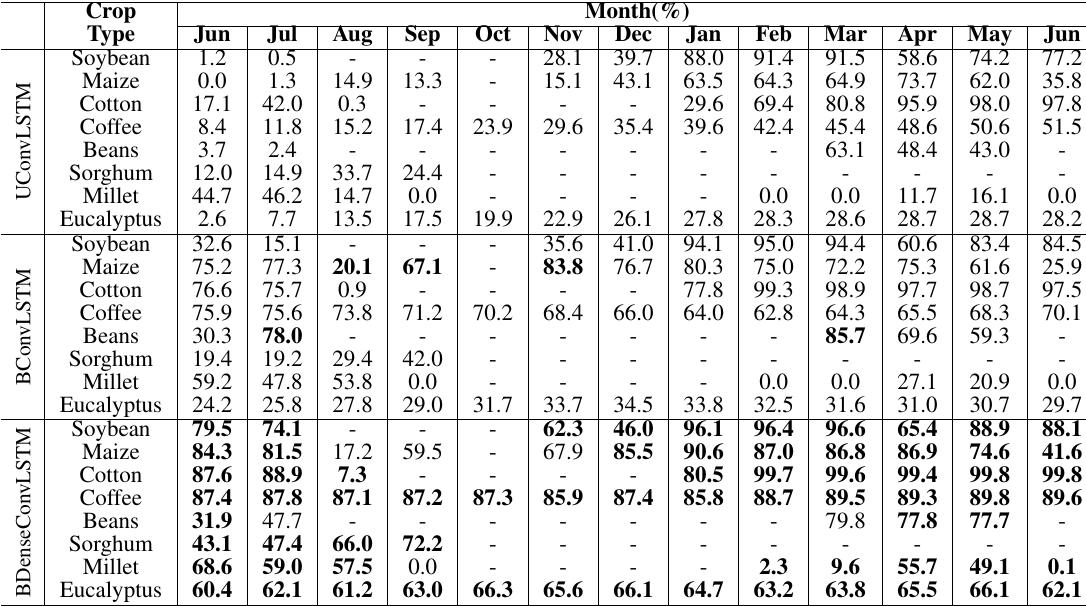
Table 5. F1 score for most relevant crop types in LEM study area, computed at each date. The sequence starts in June 2017 and ends in June